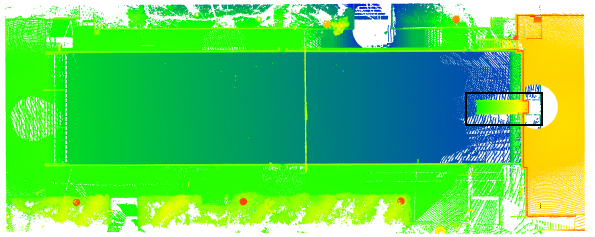
Figure 6. TLS reference point cloud with location of